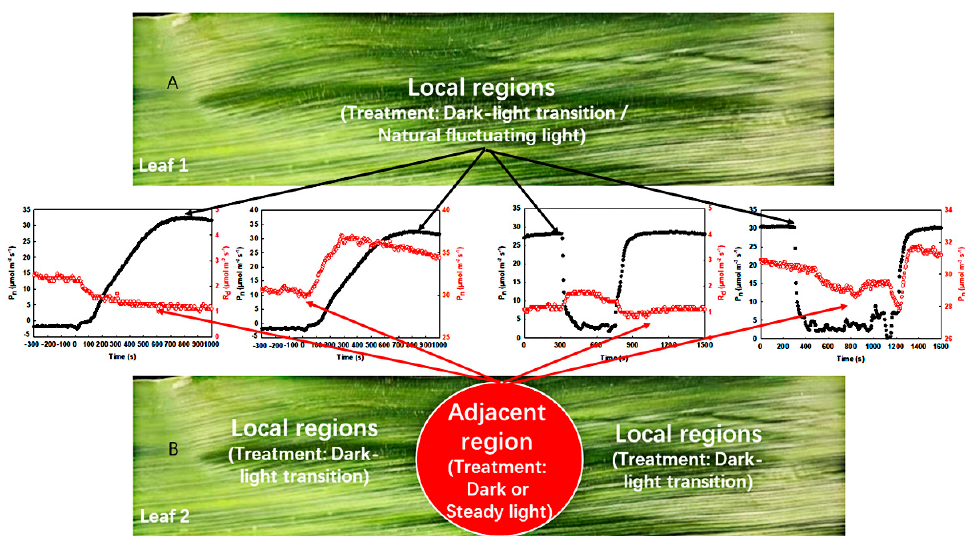
Figure 3. Schematic of gas exchange measurement. ( A ) Photosynthetic induction under the dark–light transition or photosynthetic rate under natural fluctuating light in the local regions; ( B ) respiration in darkness or photosynthetic rate under steady light intensity in the adjacent region; dark–light transition, D–L transition; steady light treatment, SL treatment.